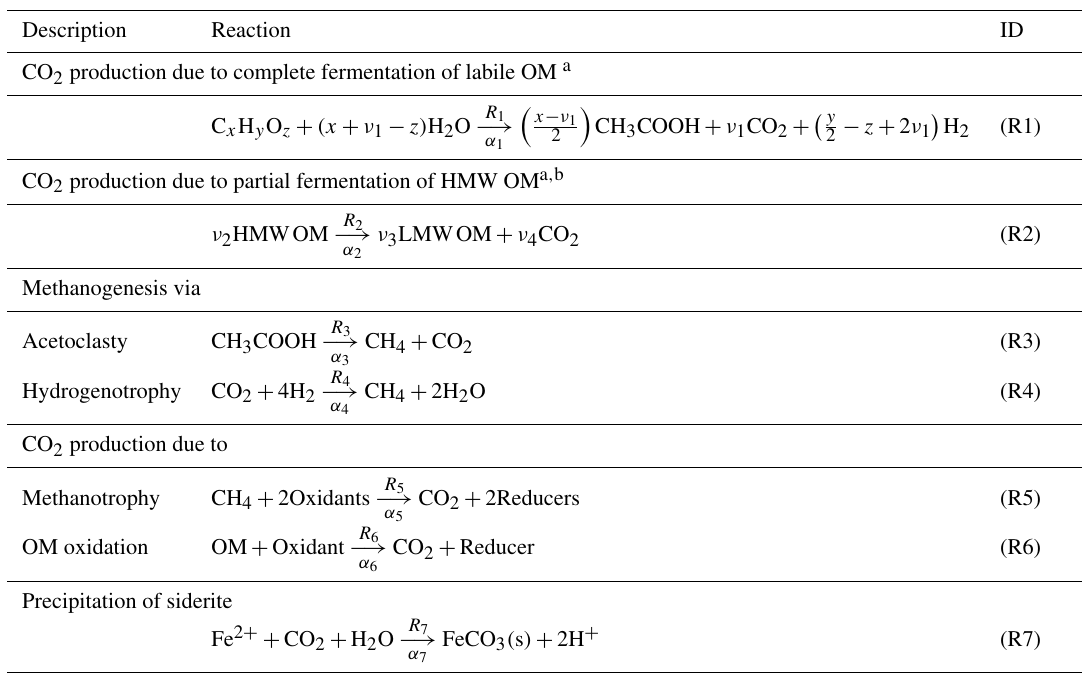
Table 1. Reactions considered (R1–R7), their reaction rates ( R 1 – R 7 ), and carbon isotopic fractionation factors ( α 1 – α 7